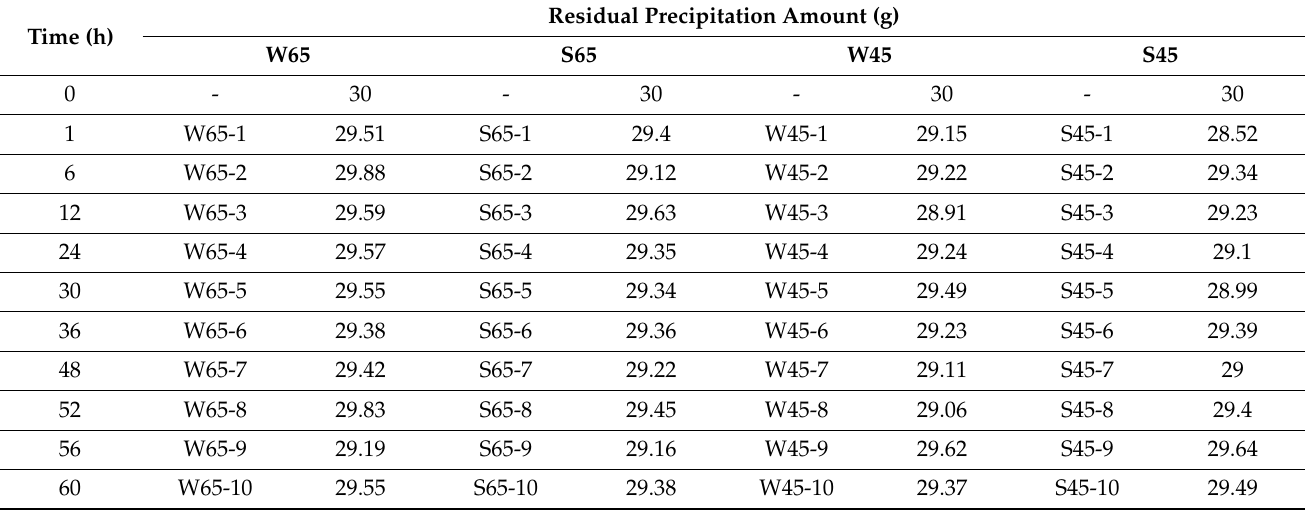
Table 2. Residual precipitation varies with time.